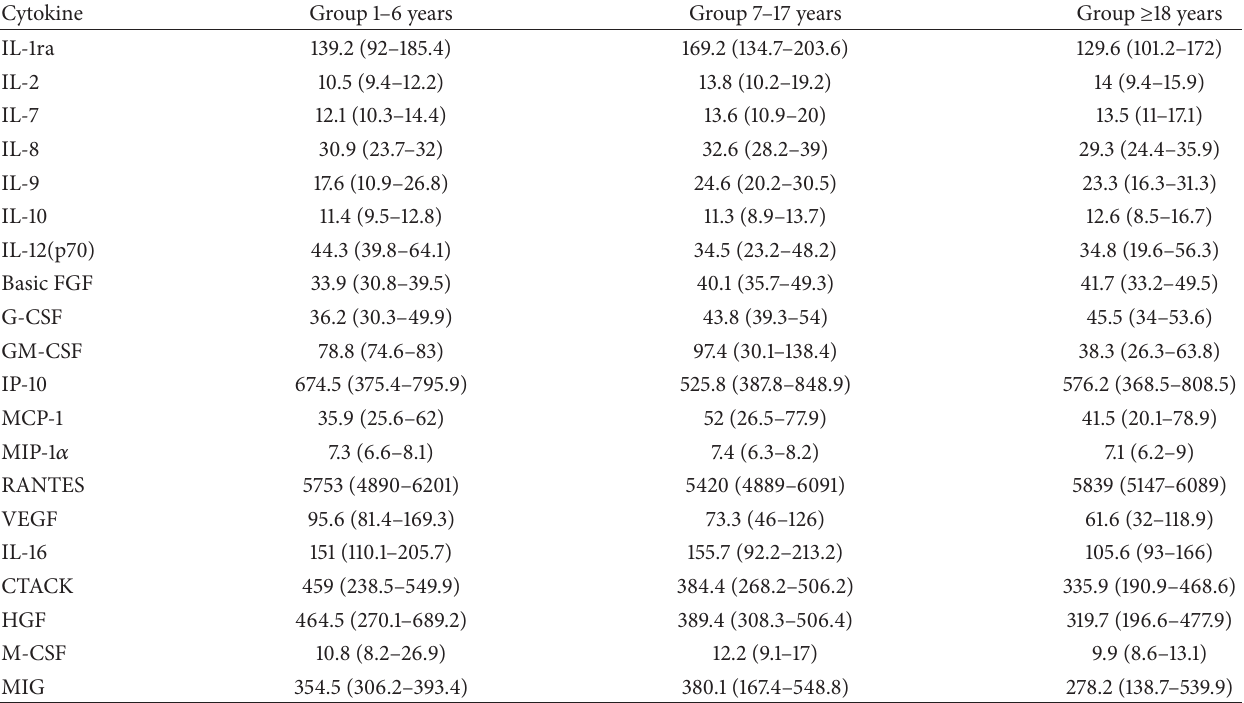
Table 3: Cytokines and chemokines showing an unchanged production amongst